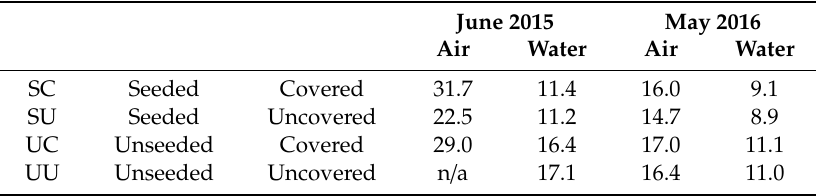
Table 3. Mean air and water temperatures for the covered / uncovered sections of the seeded / unseeded ditches. Spot temperatures at time of sampling ( n = 4 or 5).